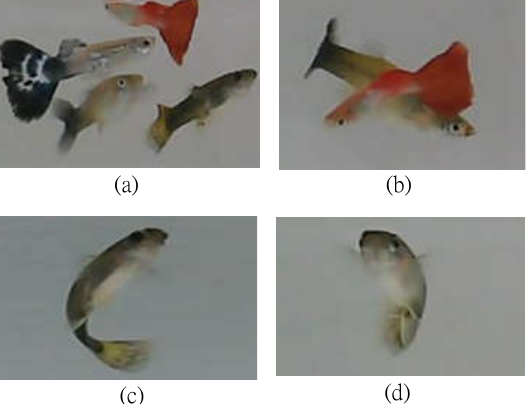
Figure 2. Illustration of fish swimming behaviors: ( a ) grouping swimming, ( b ) shading with each other, ( c ) flipping body, and ( d ) turning over for breath.